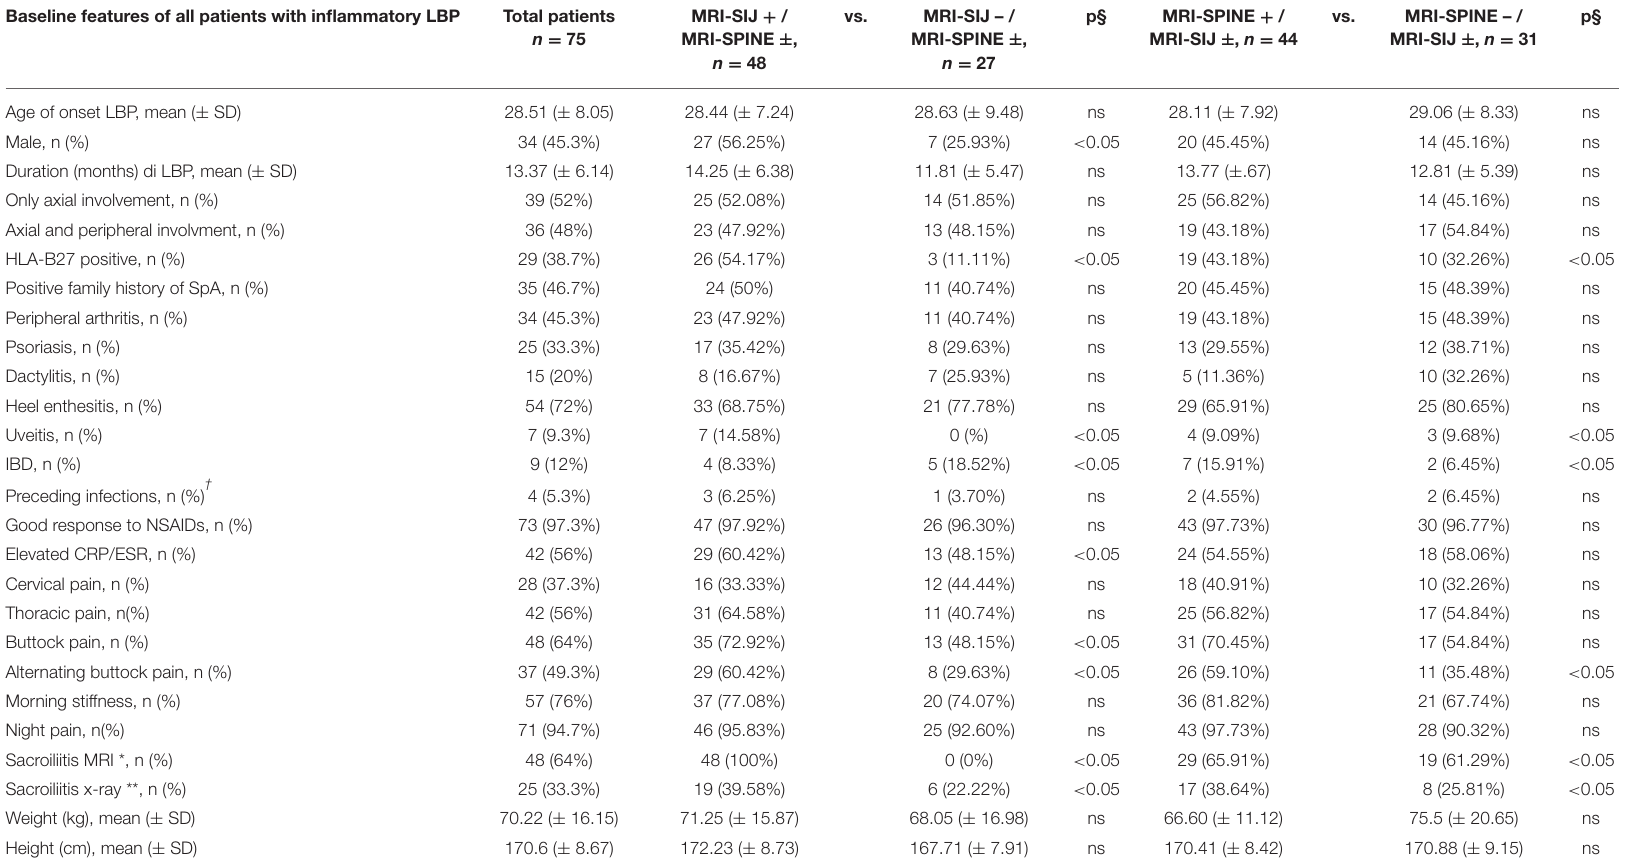
TABLE 1 | Baseline features of all LBP patients in relation to the presence of BME lesions on MRI-spine and on